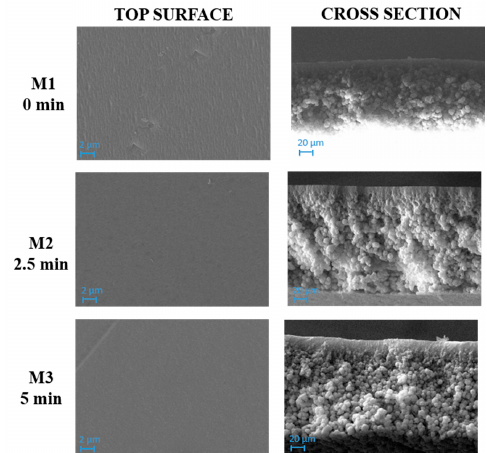
Figure 3. SEM images of M1, M2 and M3 membranes prepared with polyvinylidene fluoride (PVDF) and triethyl phosphate (TEP) and exposed for 0, 2.5 and 5 min to humidity, respectively. Magnification: top surface 10,000×, cross section 1000×.